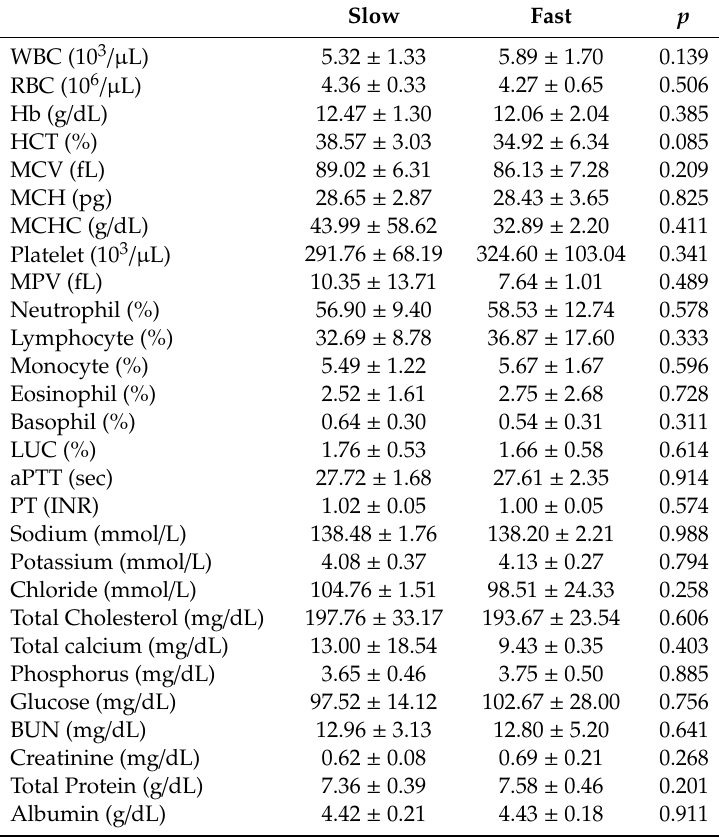
Table 2. Association of blood parameters with the proliferation of